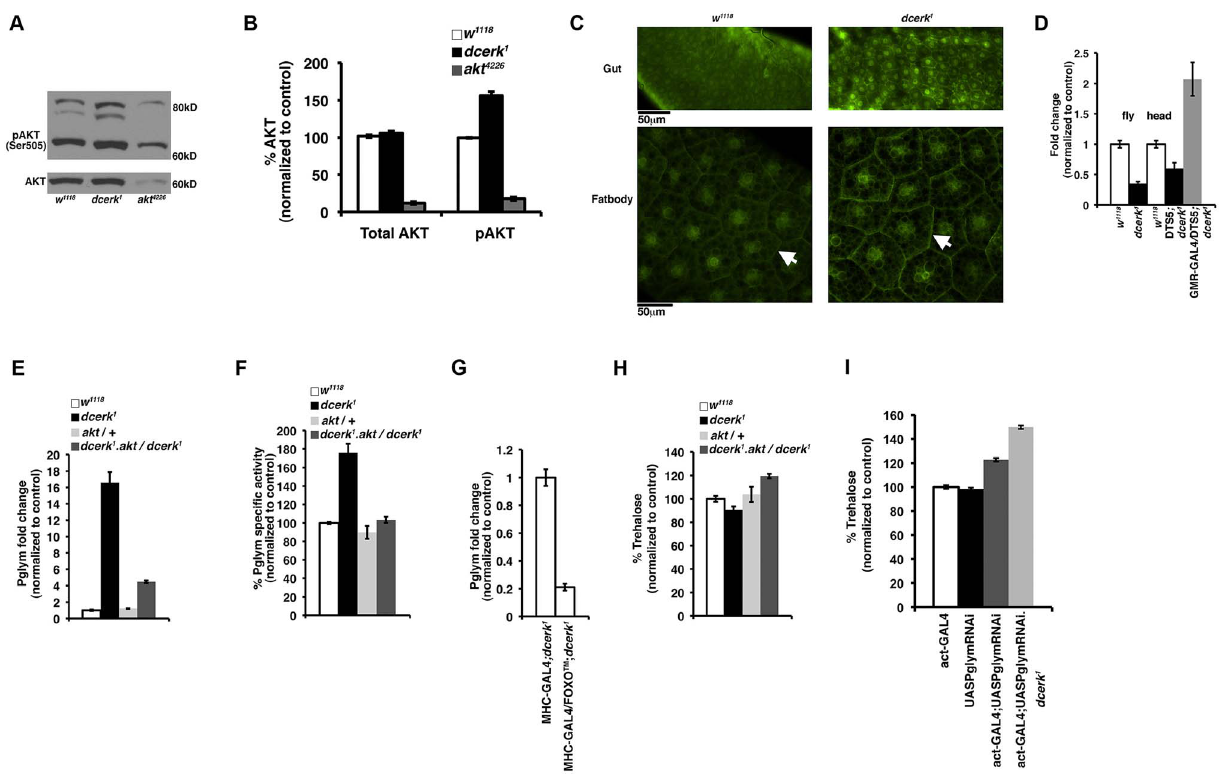
Figure 3. Increased glycolytic flux in dcerk 1 compared to w 1118 due to activation of Pglym and downstream glycolytic enzymes through AKT. (A). Total AKT and phospho AKT are monitored in control and mutant flies by Western blots. One band is observed for total AKT and it is not significantly different between w 1118 and mutant. Two major bands and one minor band are observed for phospho AKT and these are increased in dcerk 1 compared to w 1118 . The blots also show that total AKT and phospho AKT are both reduced significantly in the hypomorphic allele akt 4226 used in this study. (B). Quantification of total AKT and phospho AKT levels. Densitometric scanning of total AKT and phospho AKT bands from Western blots was carried out. The phospho AKT graph represents the average obtained after combining the values from all three bands observed on blots. The values were normalized to w 1118 taken as 100%. (C). tGPH staining is monitored in control (upper left panel) and dcerk 1 (upper right panel) adult midgut. The lower left panel shows tGPH staining in control while the lower right panel shows that in mutant larval fat body. There is increased tGPH staining at the cell membranes (compare arrows) indicating increased PIP3 levels and therefore increased PI3K activity. In addition to plasma membrane, nuclear tGPH is also increased in dcerk 1 gut since it has been reported that nuclear tGPH is also visible in many cell types when PIP 3 levels are increased in cells. Midguts from 15–20 flies were visualized in each experiment and three independent experiments were carried out. For visualizing tGPH in fat body, 15–20 early third instar larvae were used in each experiment and three independent experiments were carried out. Scale bar represents 50 m m. (D). FOXO transcript level is measured by QPCR and shows a 60% reduction in in dcerk 1 flies compared to w 1118 . FOXO transcript level increases in the mutant heads when proteosomal degradation is inhibited by overexpressing DTS5 subunit in dcerk 1 photoreceptors compared to w 1118 or DTS5 without driver in dcerk 1 head samples. (E, F). Transcript level (E) and enzyme activity (F) of Pglym are significantly decreased when AKT activity is genetically reduced in dcerk 1 suggesting AKT mediates Pglym activation in dcerk 1 . (G). Overexpression of constitutively active FOXO in the muscles (MHC-GAL4) significantly decreases whole body Pglym transcript level. n=3, error bars represent standard deviation. (H). Reduction of AKT in dcerk 1 increases total body trehalose level. Trehalose level is calculated per mg of protein and normalized to w 1118 level. n=3, error bars represent standard deviation. (I). While actin GAL4 driver or UASPglymRNAi transgene individually have no effect on trehalose level, combining them increases whole animal trehalose by 20% in w 1118 and 50% in dcerk 1 . n=3, error bars represent standard